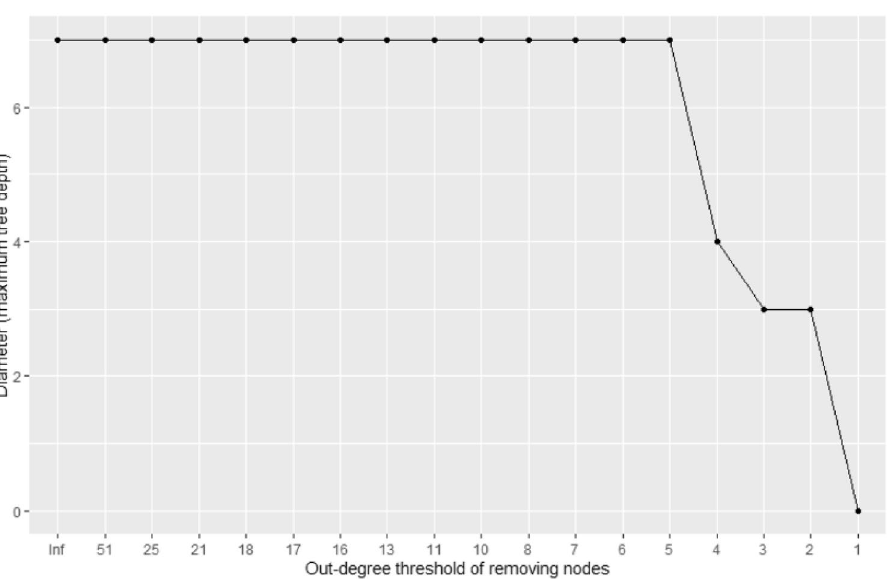
Figure 6. The change in the network’s diameter as we remove the nodes whose out-degree is equal to or larger than the